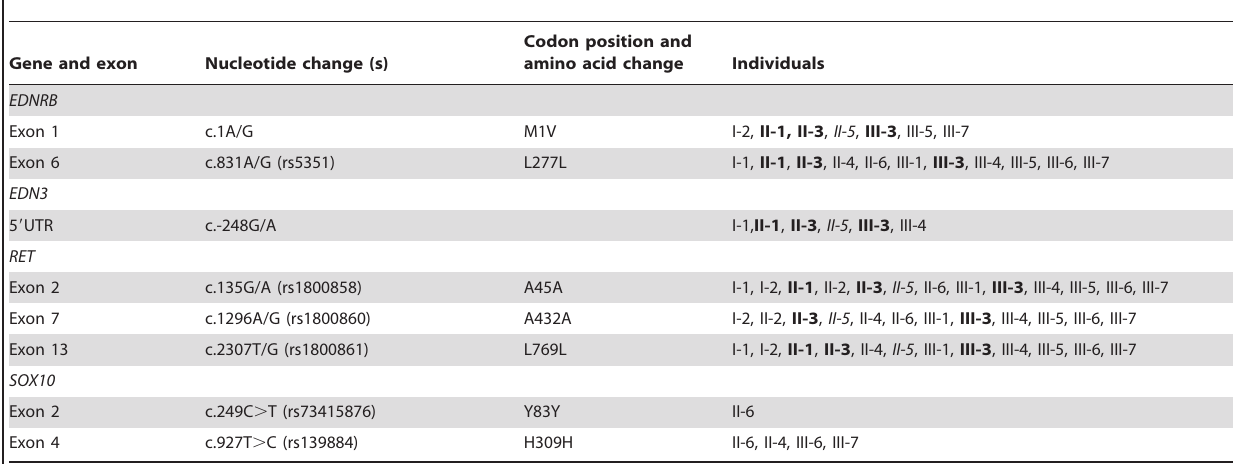
Table 1. Sequence variants of EDNRB , EDN3 , RET and SOX10 identified.